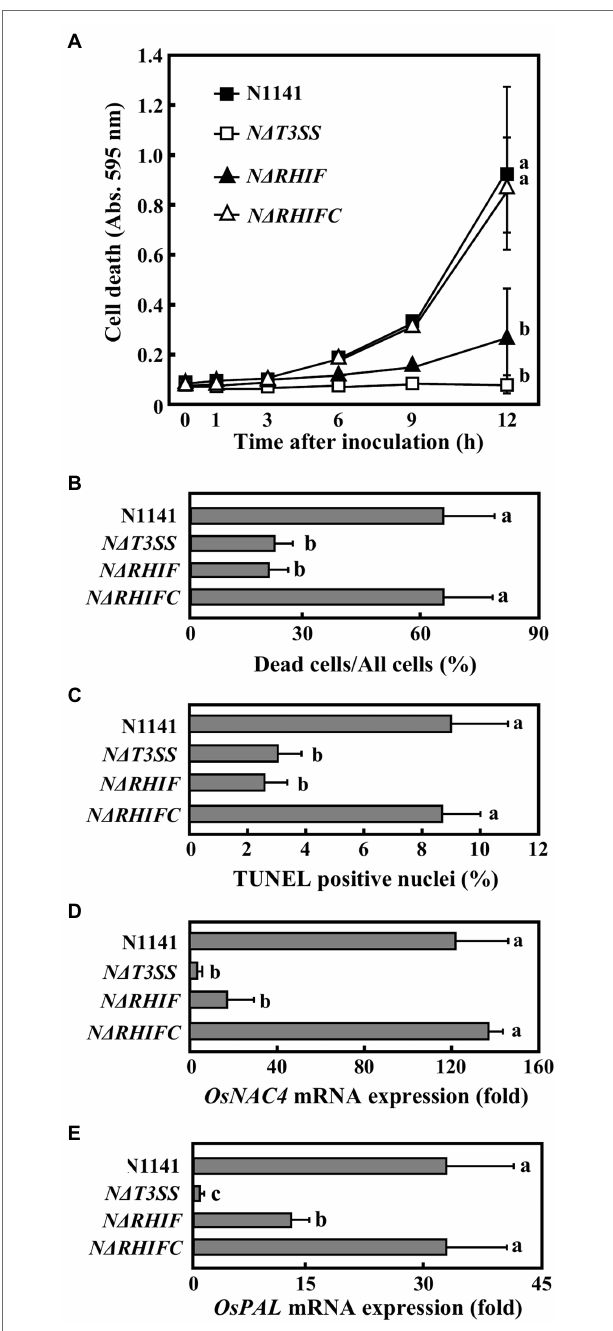
FIGURE 3 | Role of RHIF in induction of rice ETI. (A) Time course of HR cell death in cultured rice cells inoculated with N1141 (solid square), N Δ T3SS (open square), N Δ RHIF (solid triangle), or N Δ RHIFC (open triangle). That time point values without letters indicate no statistical significance. (B) Percentage of dead cell in leaf sheath sections. Rice sheath cross-sections 6 h after treatment with N1141, N Δ T3SS , N Δ RHIF , and N Δ RHIFC were monitored for dead cells using Evans blue staining. Each determination was done with at least 100 cells in each experiment. (C) Percentage of TUNEL-positive nuclei in cultured rice cells inoculated with N1141, N Δ T3SS , N Δ RHIF , and N Δ RHIFC . The percentage of TUNEL-positive nuclei was determined by counting nuclei within 10 individual fields. Each determination was done